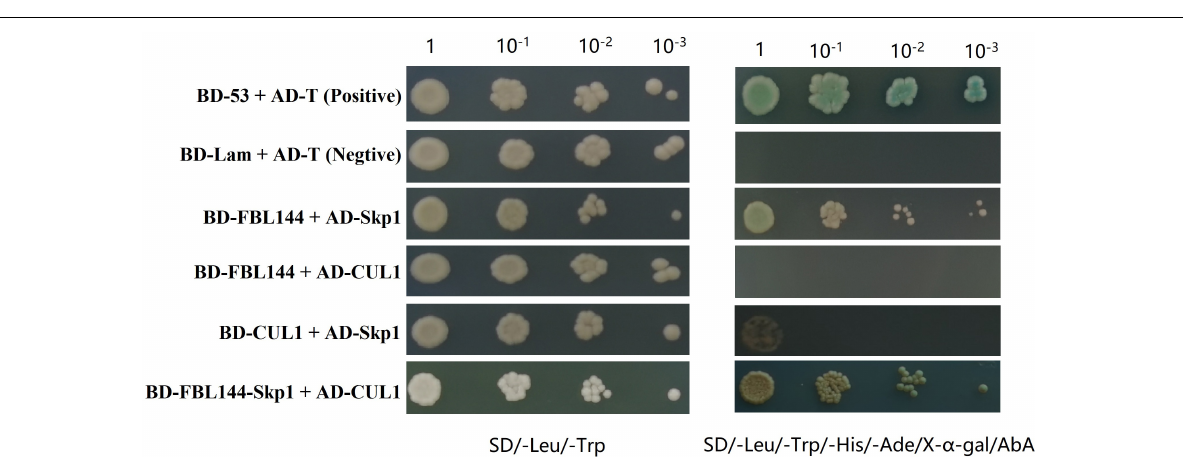
FIGURE 6 | GmFBL144 was a key subunit of SCF FBL 144 . GmFBL144 can interact with GmSkp1, and the complex of GmFBL144-GmSkp1 can promote the interaction of GmSkp1 with GmCUL1. The interactions between pGADT7-T and pGBKT7-53, pGADT7-T and pGBKT7-Lam were used as positive and negative control, respectively. AbA, aureobasidin A. X- α -gal, 5-bromo-4-chloro-3-indoxyl- α